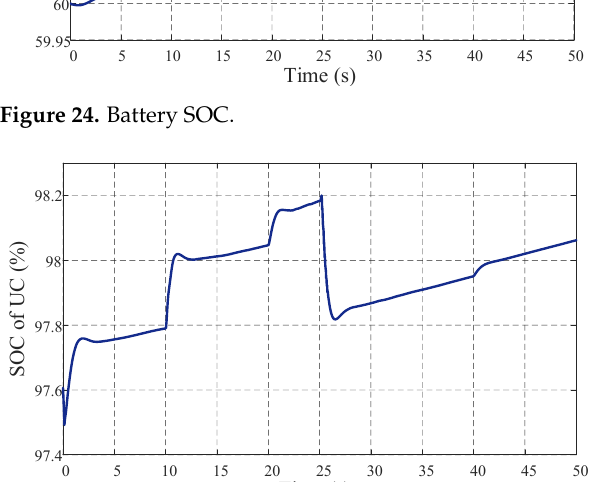
Figure 25. Ultracapacitor